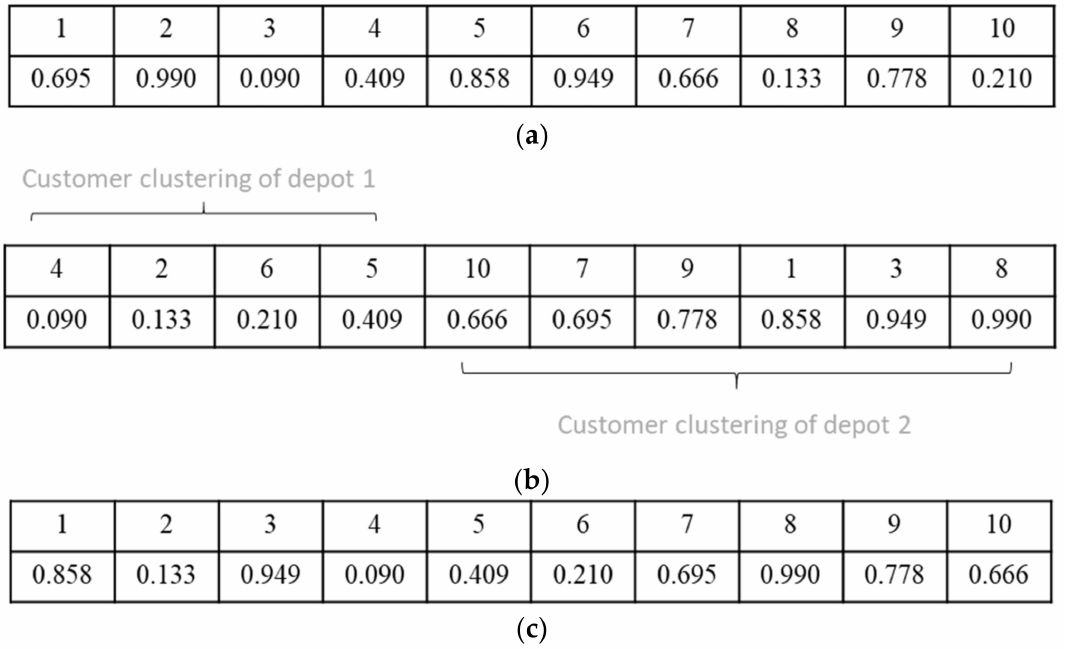
Figure 5. Initial solution translation of HSADE. ( a ) Current vector (before the initial solution translation); ( b ) Initial solution by constructive heuristic; ( c ) Current vector (after the initial solution